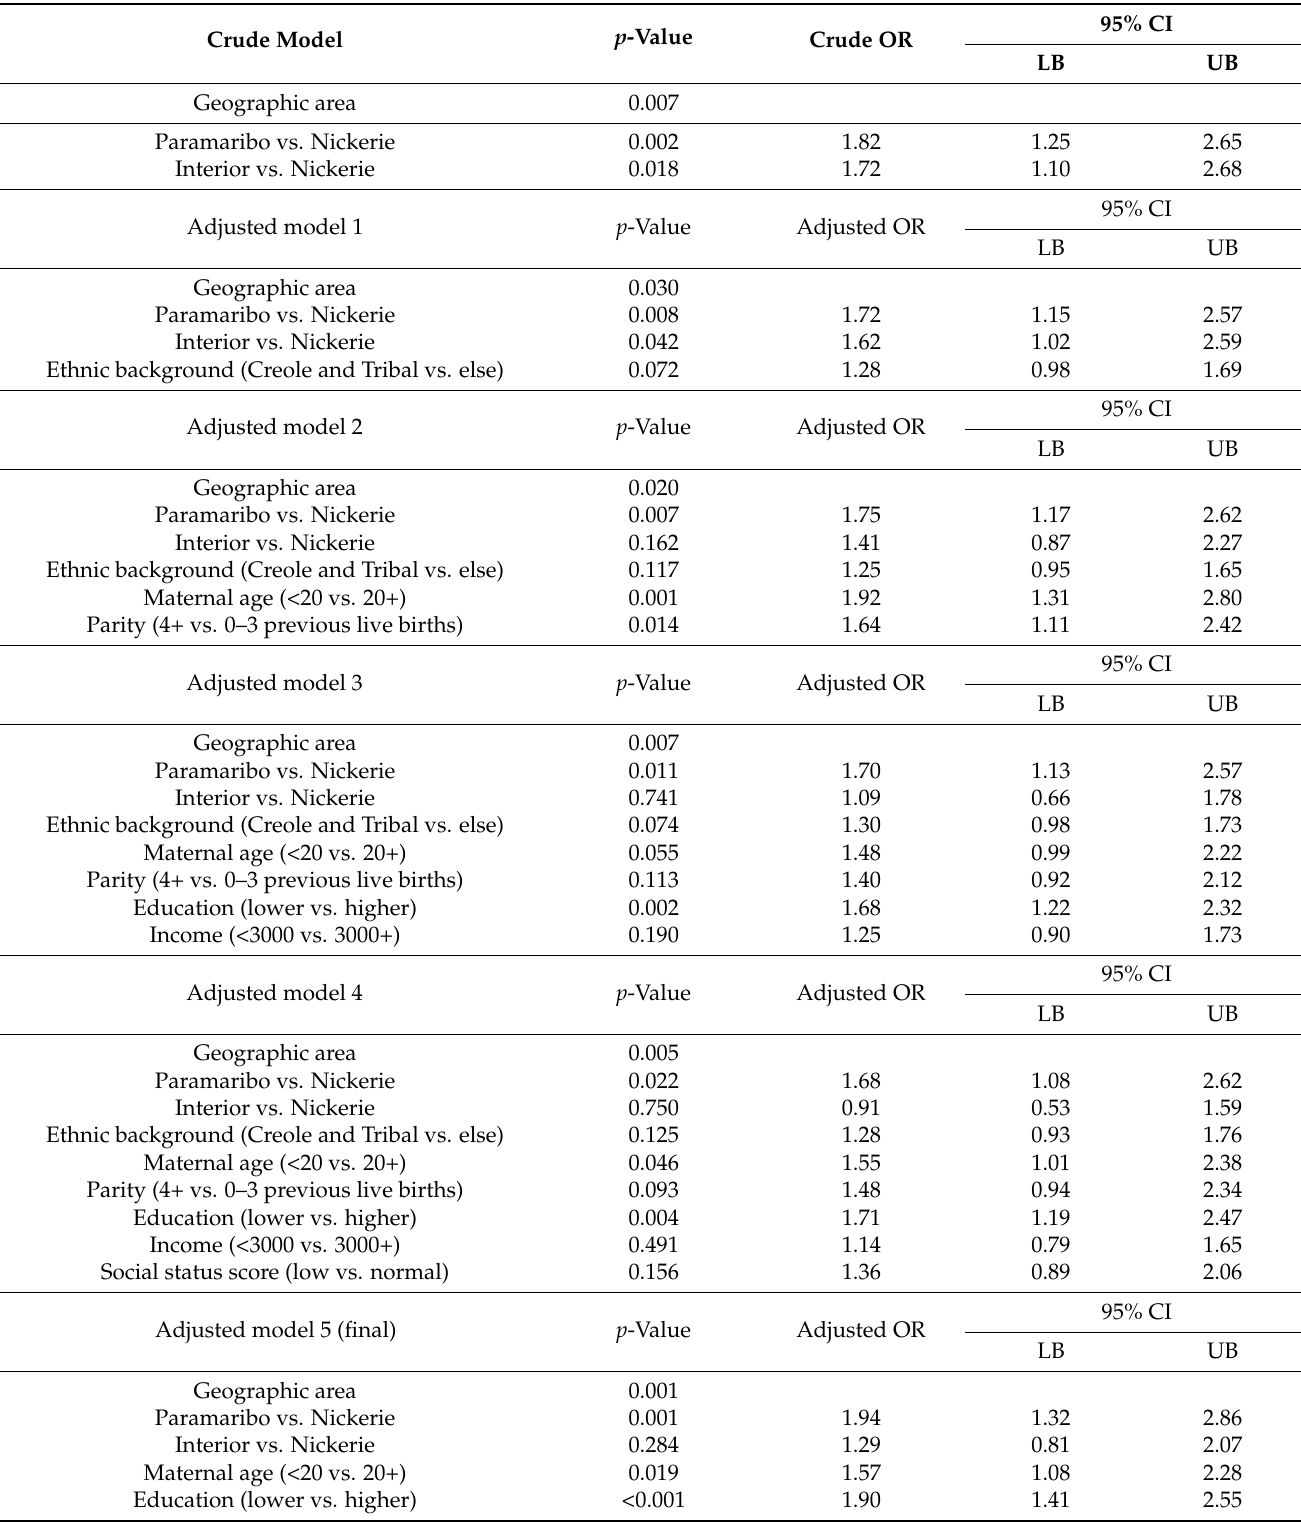
Table 3. Crude and adjusted odds ratios (OR) for high perceived stress with 95% confidence inter- vals